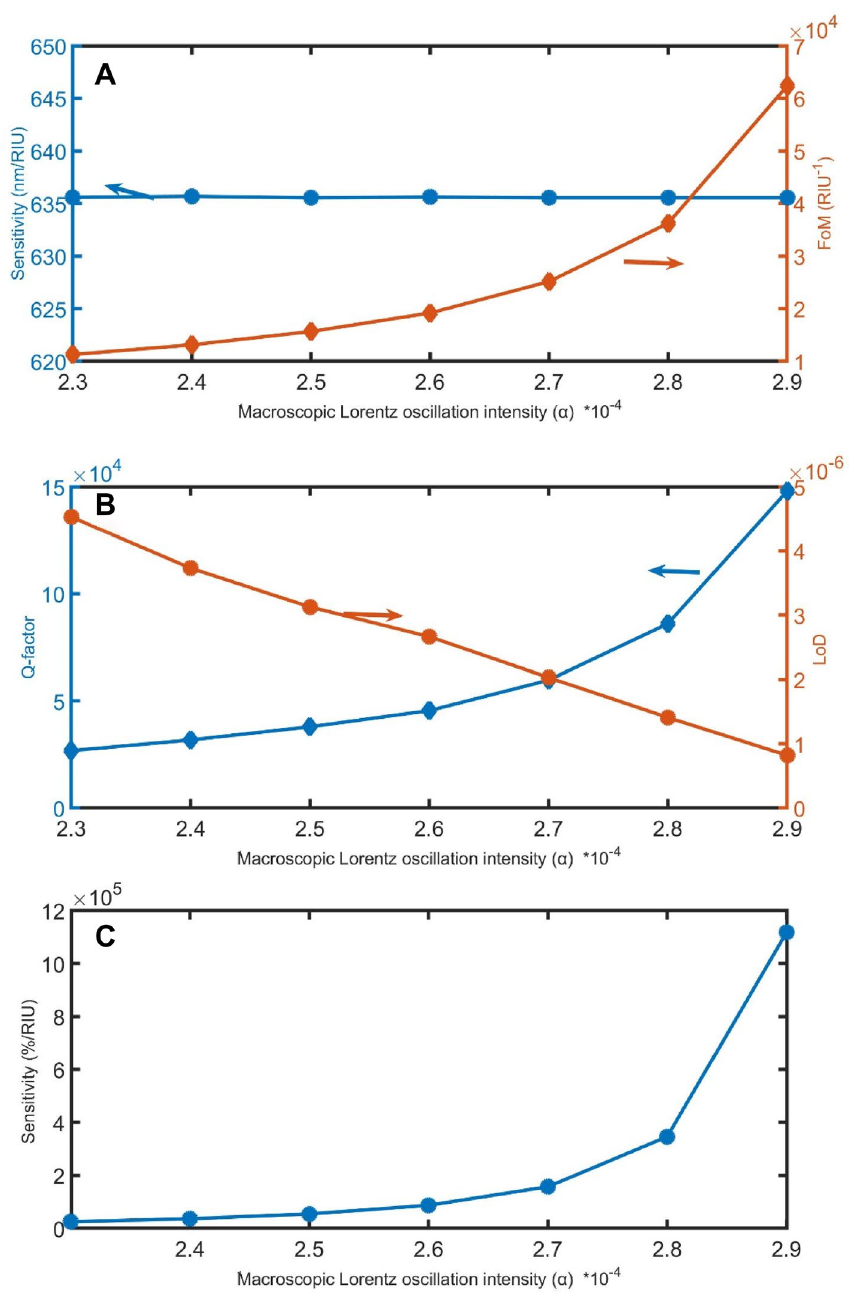
Figure 5. The impact of α on ( A ) sensitivity in nm/RIU and FoM, ( B ) Q and LoD, and ( C ) sensitivity in